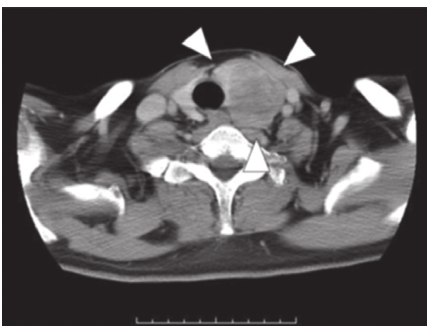
Figure 1: Imaging studies before the thyroidectomy. Contrast- enhanced CT showed a tumor in the left lobe of the